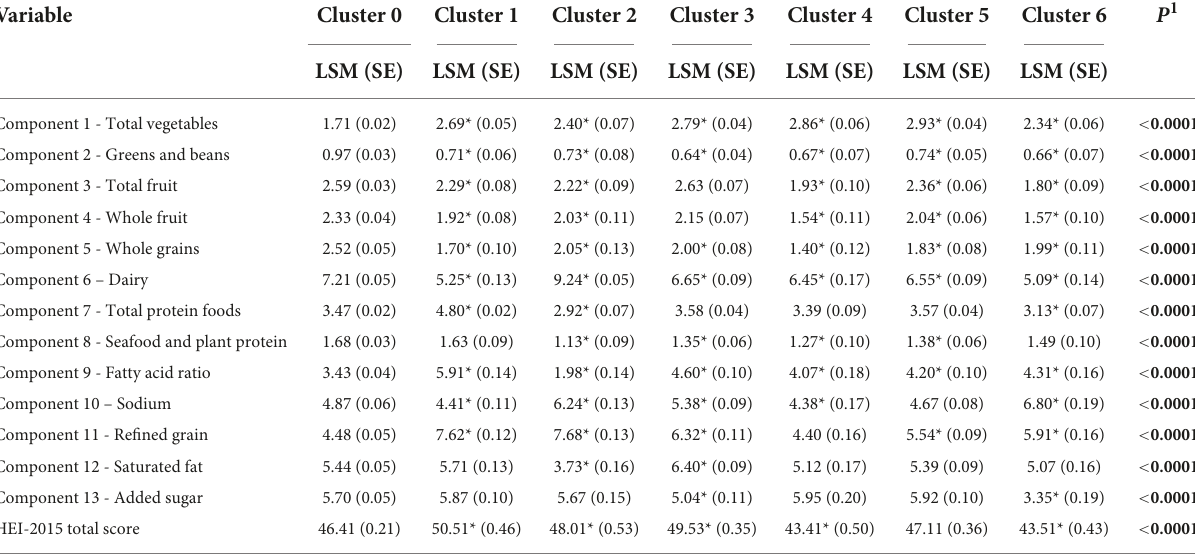
TABLE 3 Least square mean total and subcomponent Healthy Eating Index 2015 scores by potato cluster in American children and adolescents.